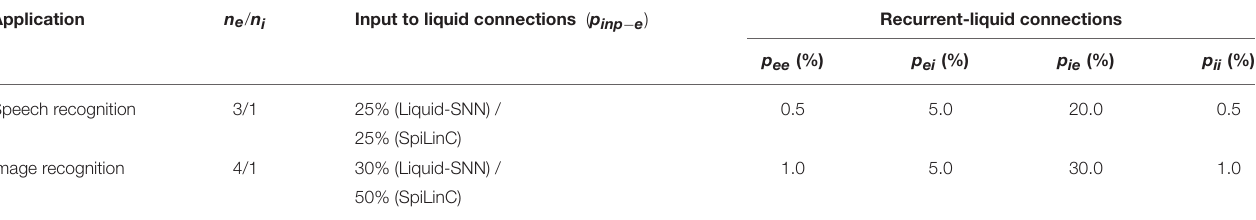
TABLE 1 | Synaptic connectivity parameters.